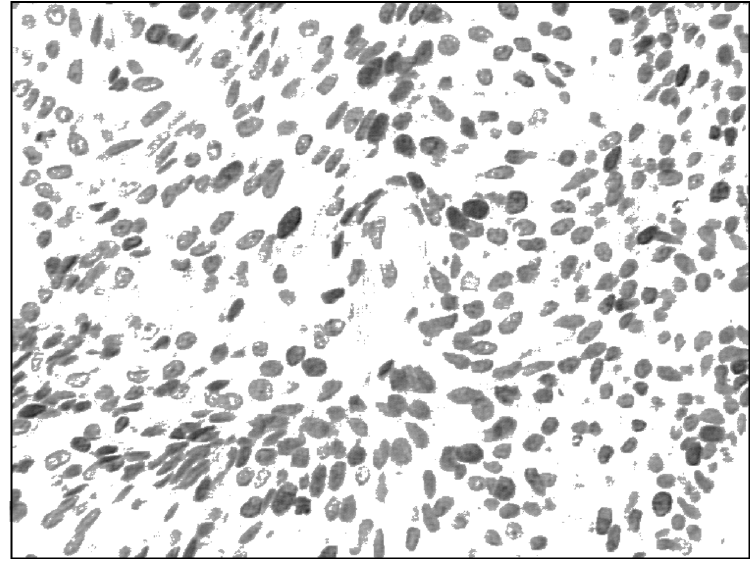
Fig. 6. Segmented nuclei in specimen. After this segmentation the stored classifier can be applied.